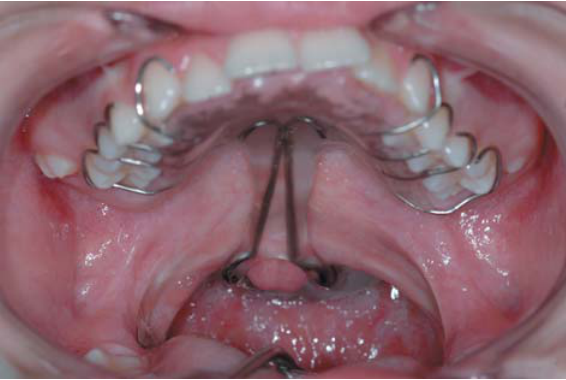
Figure 2- Intraoral speech